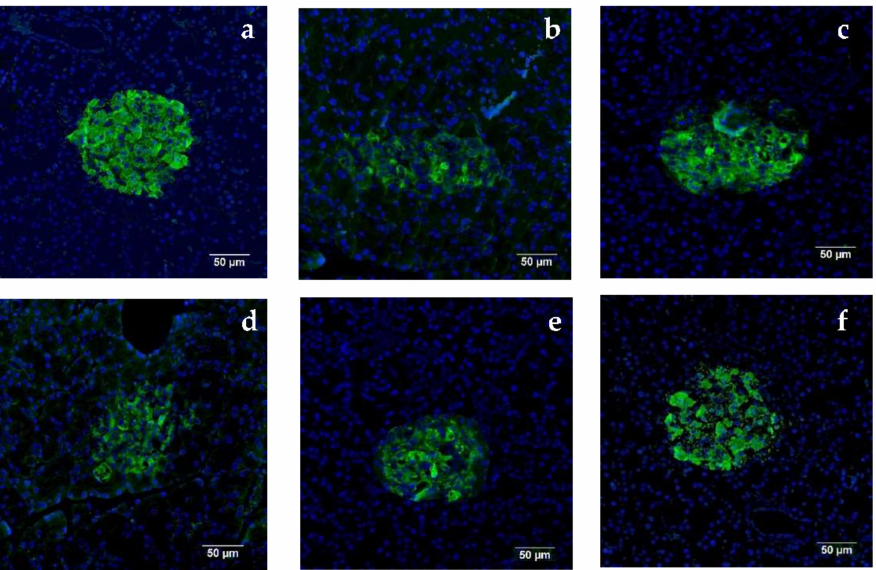
Figure 6. Effects of oral SS administration on pancreatic immunofluorescence staining in T2D rats ( × 400) ( a ), normal group; ( b ), diabetic model group; ( c ), metformin administration; ( d ), 1% SS(LSS); ( e ), 2.5% SS (MSS); and ( f ), 5% SS (HSS)